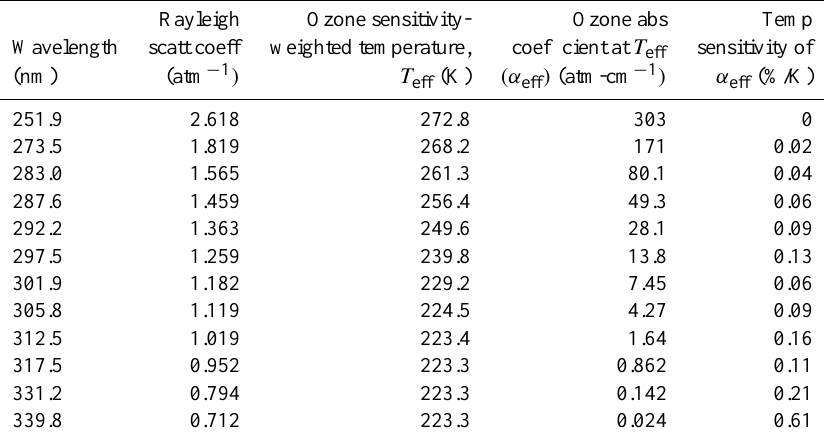
Table 1. Spectroscopic parameters for the NOAA-17 SBUV/2 sensor calculated assuming 1.1nm triangular slit function, Rayleigh scattering coefficient with height due to change in gravity and band-averages the radiances calculated using ozone and temper- ature profiles for improved